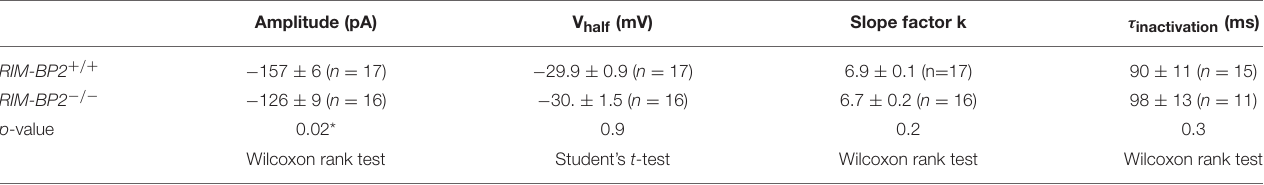
TABLE 1 | Summary of Ca 2 + -current (I Ca ) data from perforated patch-clamp